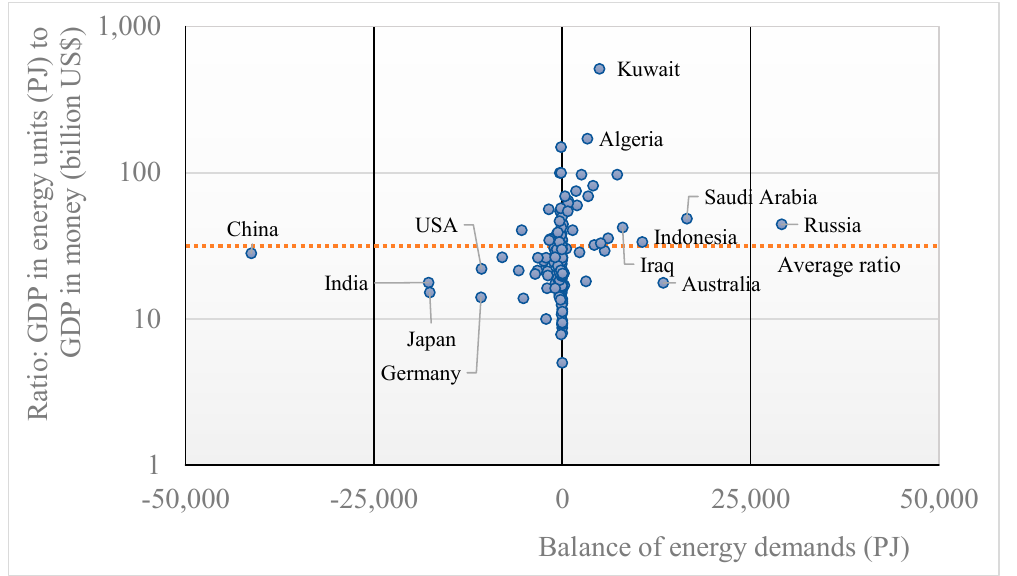
Figure 8. Ratio of GDP expressed in energy units to GDP in money (USD) vs. the balance of energy demand.